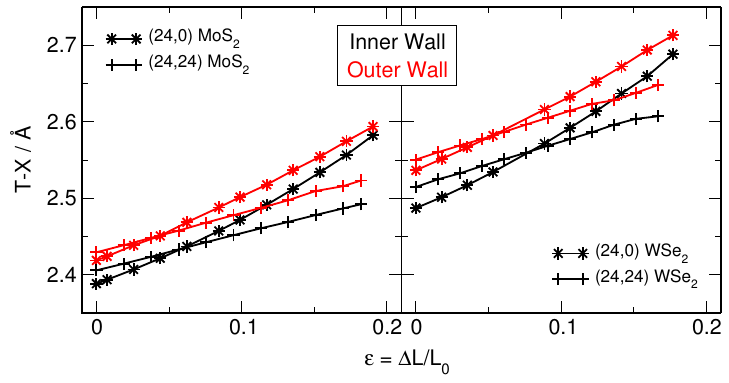
Figure 2. The metal-chalcogen bond length (T–X) change with the applied tensile strain of exemplary MoS and WSe NTs. Similar linear changes are obtained for other transition- 2 2 metal dichalcogenide-NTs.